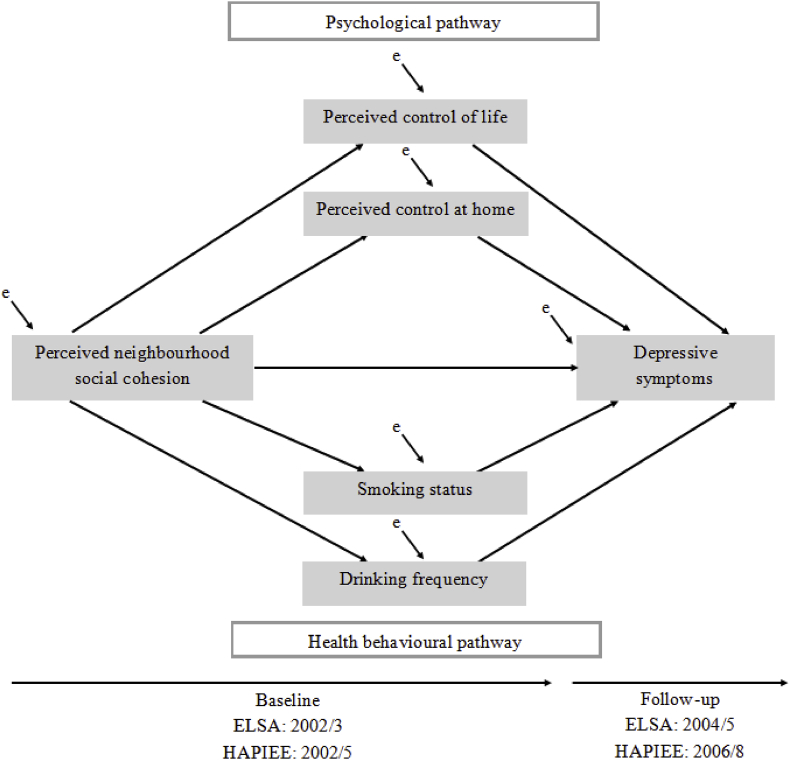
Path model of relations between perceived neighbourhood social cohesion and depressive symptoms, ELSA and HAPIEE. For simplicity, independent exogenous variables (age, gender, country (HAPIEE only), educational attainment, marital status, self-rated health, number of limitations in activities of daily living and probable depressive cases) of the model are not depicted in the figure. The exogenous variables are included as predictors of PSC and depressive symptoms.